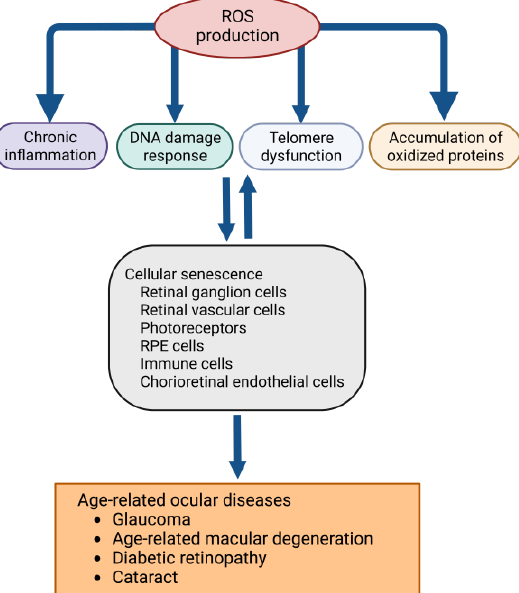
Figure 1. Biological roles of oxidative stress in cellular senescence in the retina.